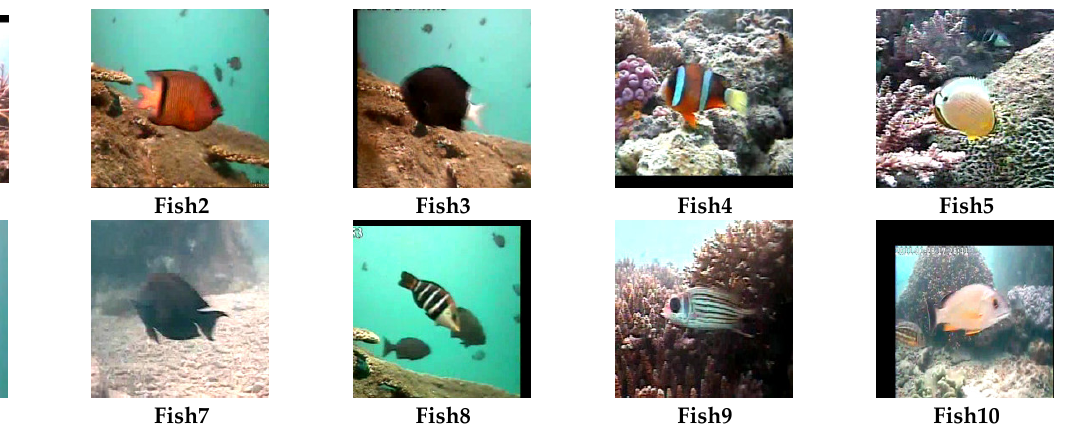
Figure 6. Fish4Knowledge dataset.